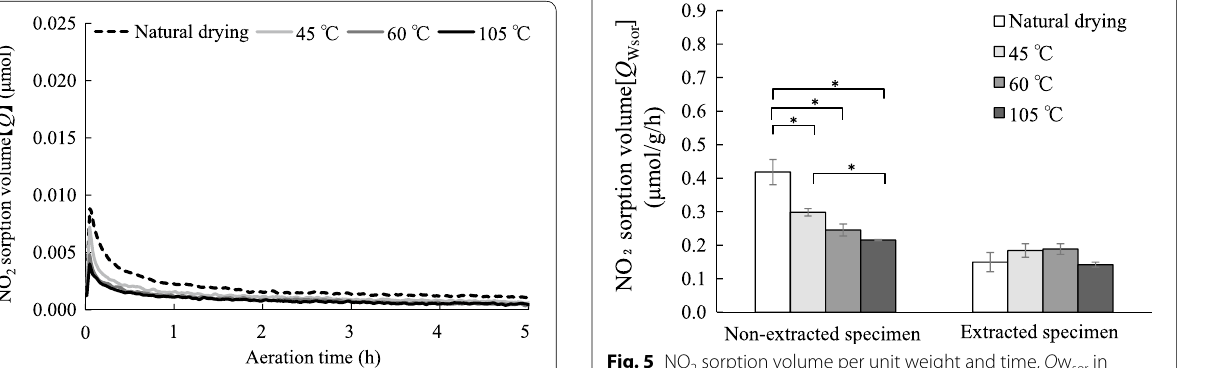
Fig. 3 Variation over time in NO 2 sorption volume, Q of specimens under different drying conditions. The moisture content in the specimens was 0%. ( n 3) =